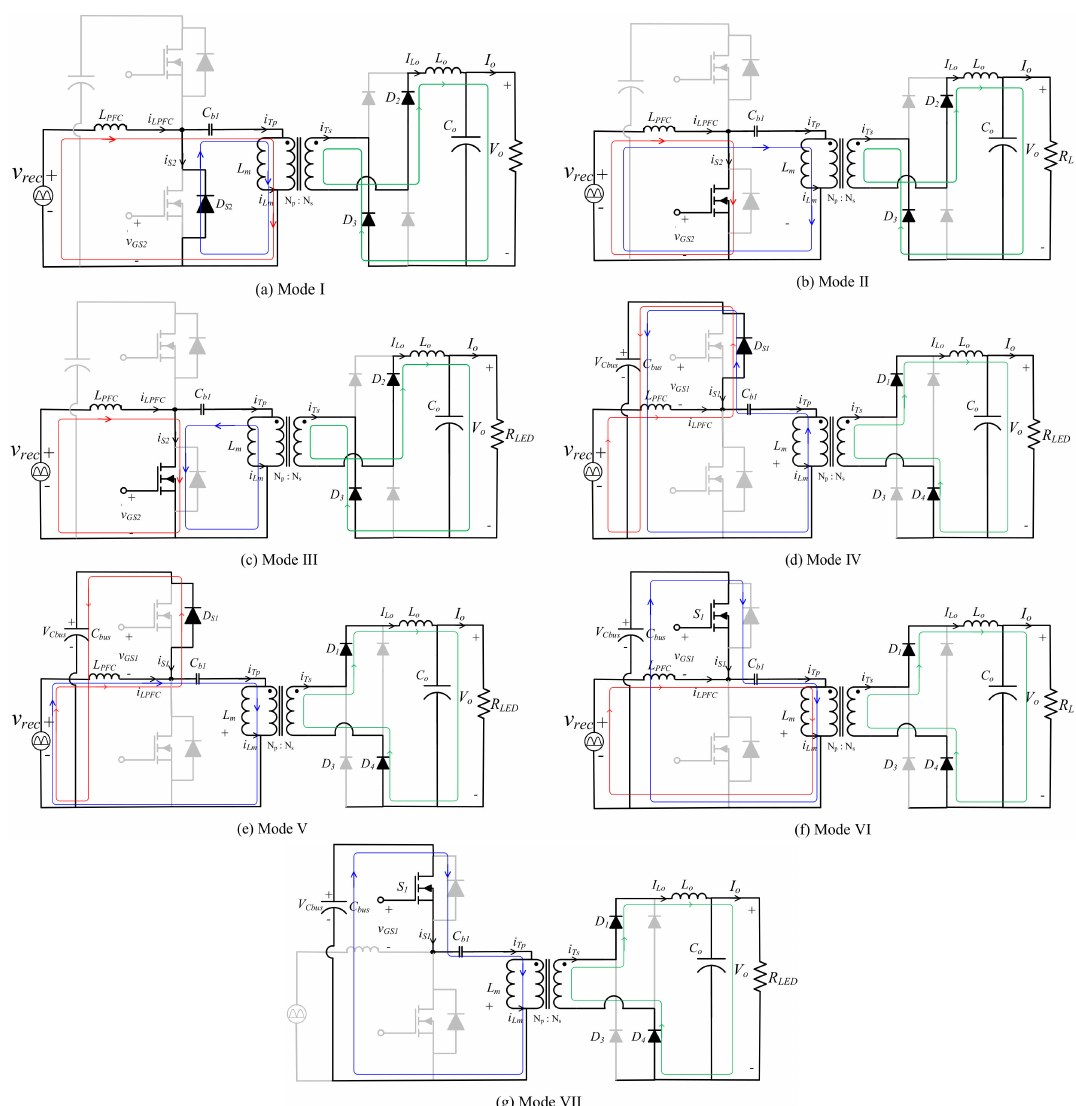
Figure 2. Operation modes. ( a ) Mode I, ( b ) Mode II, ( c ) Mode III, ( d ) Mode VI, ( e ) Mode V, ( f ) Mode VI, ( g ) Mode